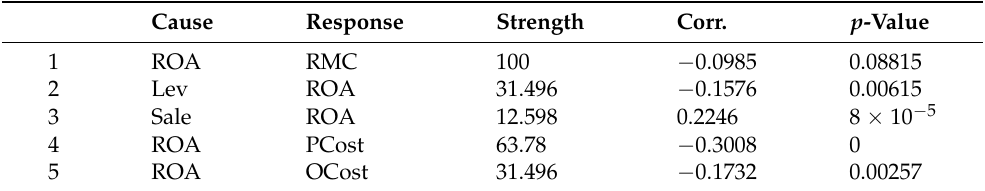
Table 3. If ROA is in the ‘cause’ column, that variable in the response column has a potential endogeneity problem. See generalCorr::causeSummBlk() for vignettes and details. Cause